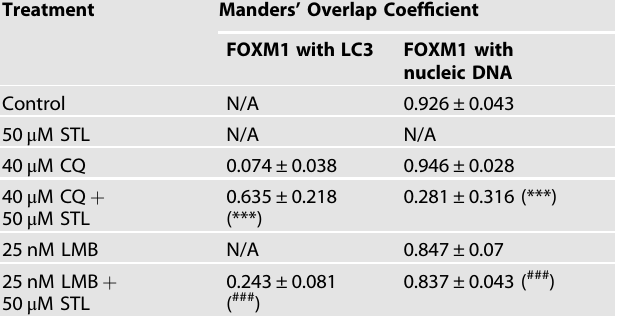
Table 2. Colocalization of EGFP-FOXM1 with cytoplasmic LC3-positive vesicles or DAPI-stained nuclear DNA (See Fig. 4b and Supplementary Fig. 7 for images).